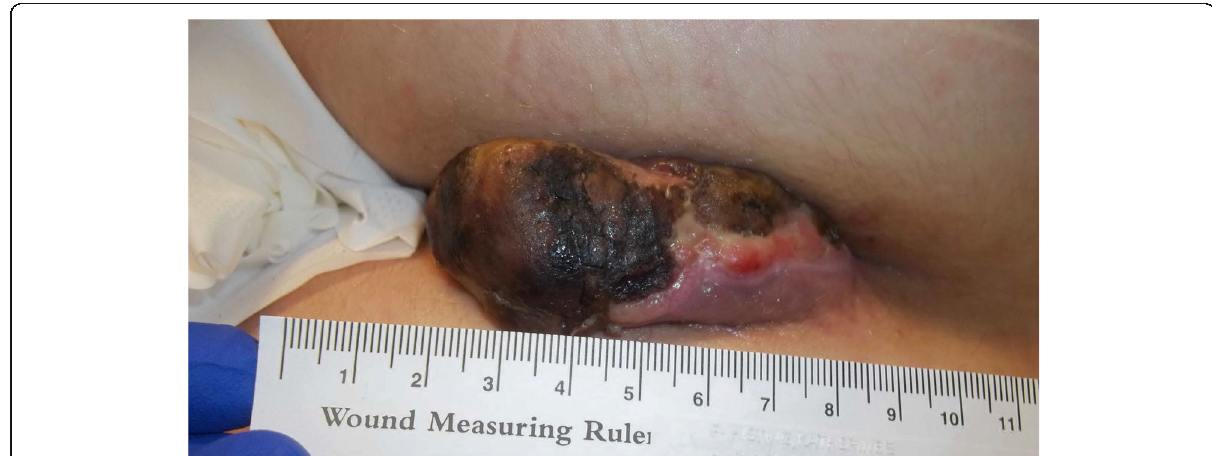
Fig. 1 Photo of intergluteal sacral tumor, taken at the time of start of induction